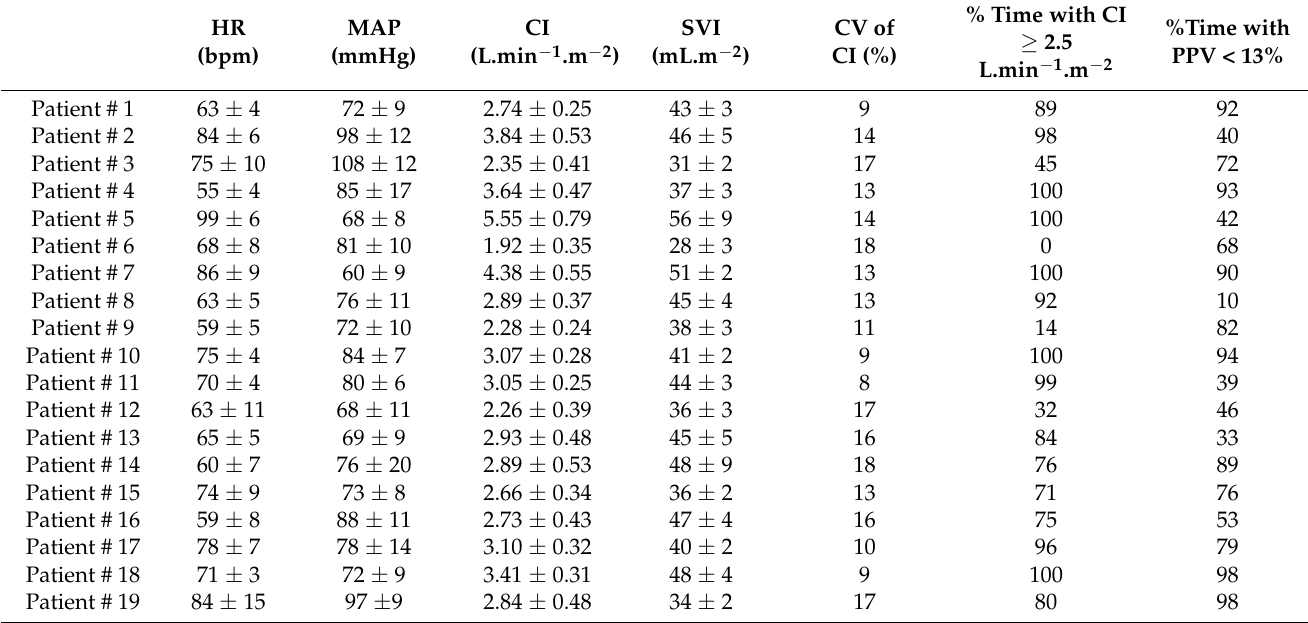
Table 2. Individual data for studied parameters per